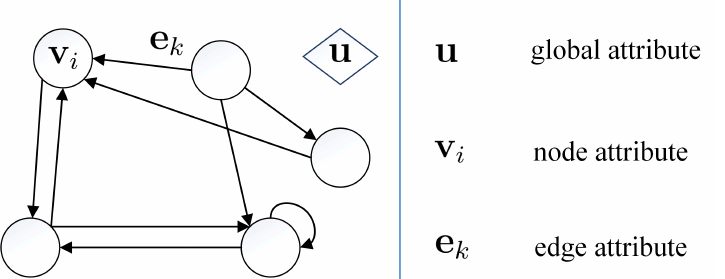
Figure 2. Graph network block (used to represent the data in the graph structure).